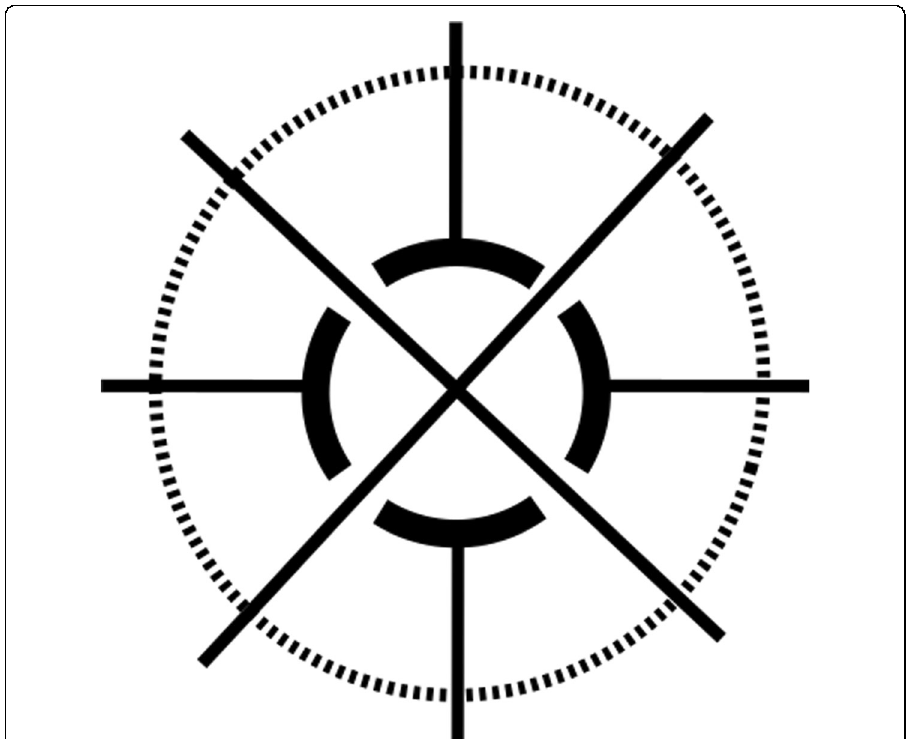
Fig. 6 Legend: The porous circle indicates EMMAs shared space established through the Gantt chart, open to those visiting the platform (horizontal and vertical lines), whereas the inner circle with four ‘ gaps ’ presents the selective shared space of the collaborative software, merely including the associates (diagonal